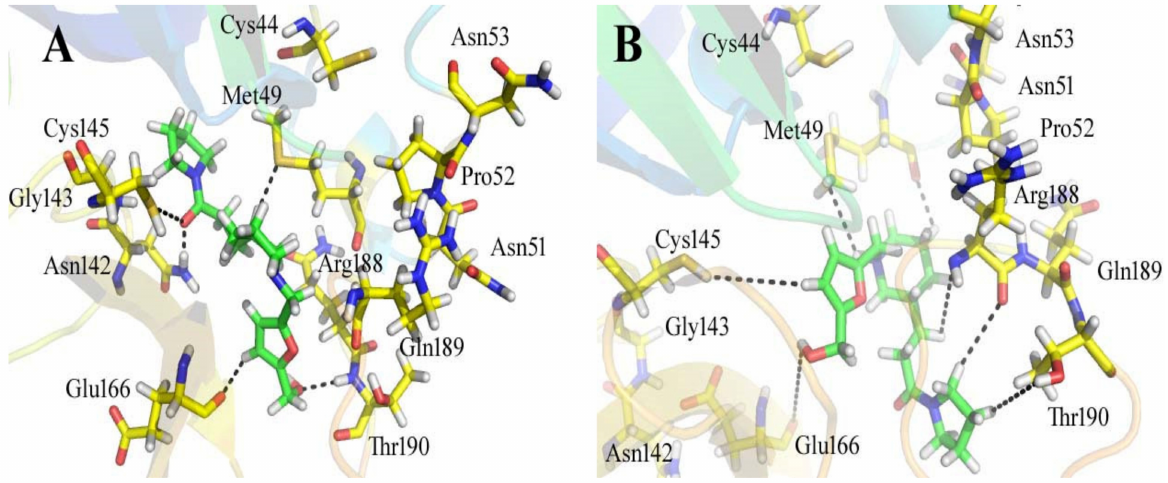
Figure 5. The active site of the M pro protein ( A ) before and ( B ) after MDS, showing the binding mechanism of the obtained inhibitor ChemBridge63310525 from the ChemBridge